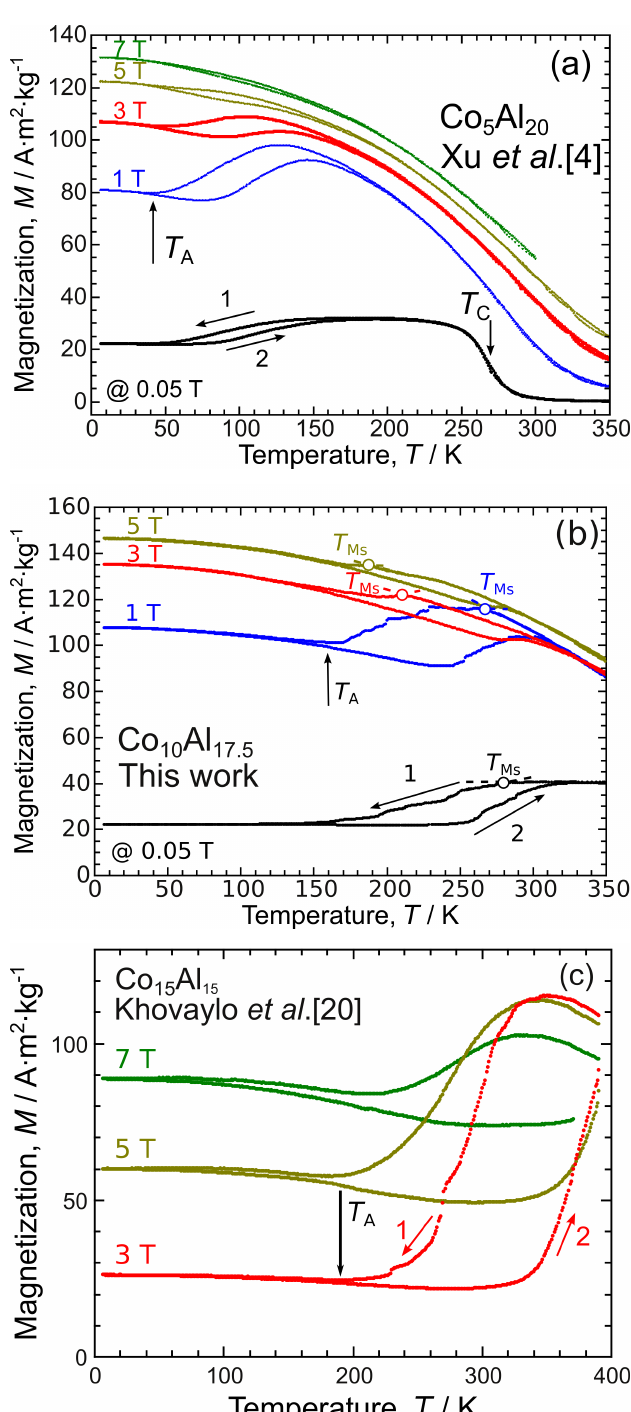
Figure 2. Thermomagnetization curves under different magnetic fields for